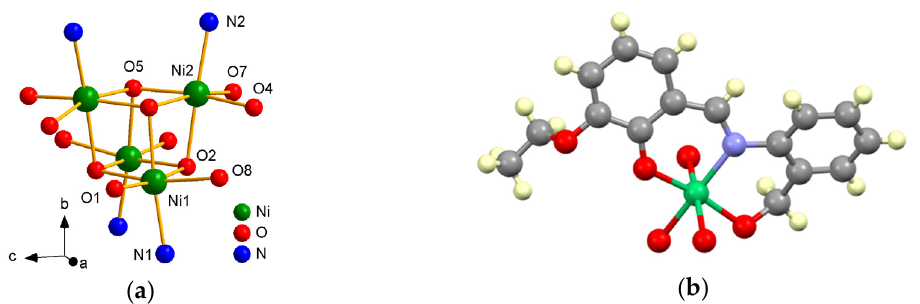
Figure 2. Crystal structures of ( a ) complex 1 (unlabeled atoms are related to the symmetry operation 1 – x, y, 3/2 – z.) and of ( b ) complex 2 . Hydrogen atoms except for those related to hydrogen bonds have been omitted for clarity. Intramolecular O–H···O hydrogen bonds are shown as dashed lines.